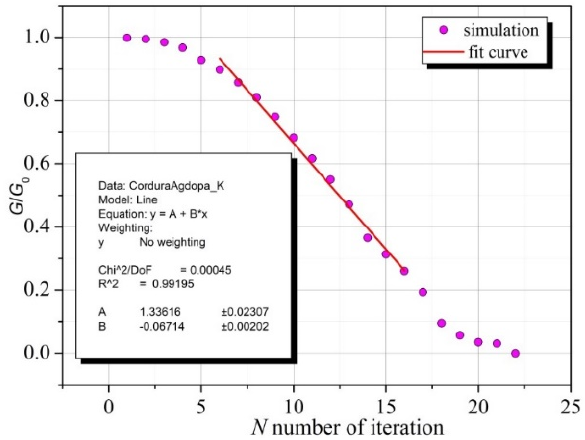
Figure 10. Fitting part of the results of the selected simulation (see Figure 6) with a linear function: g ( N ) = A + BN . The inset presents the values of factors calculated during fitting the simulation and experimental data.